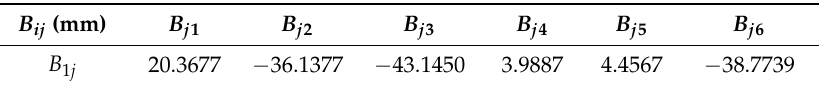
Table 3. Calibration result of parameter B .